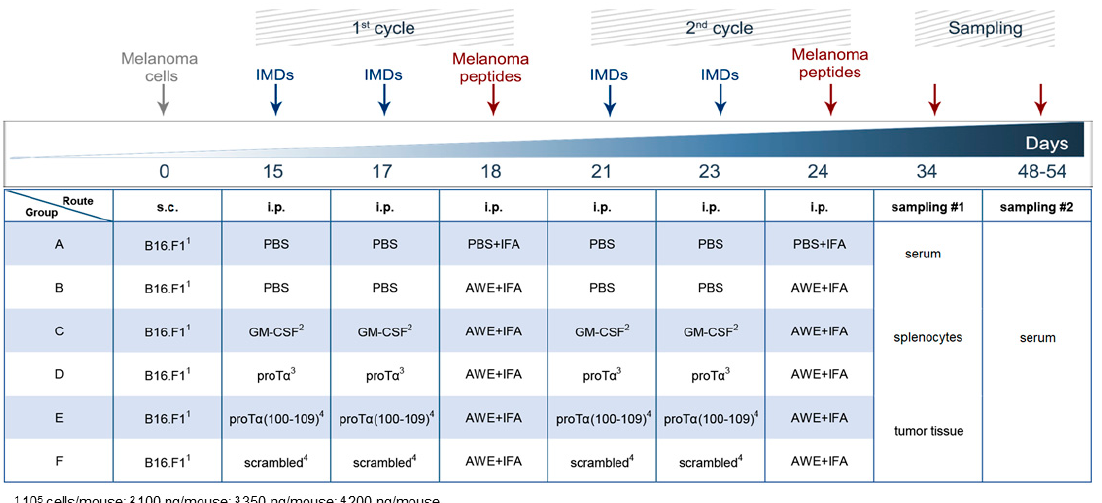
Figure 1. In vivo protocol used to assess effect of proT α and proT α (100–109). Day 0: Mice inoculated subcutaneously (s.c.) with syngeneic B16.F1 melanoma cells. Days 15, 17, 21, and 23: Mice of groups C, D, E, and F administered intraperitoneally (i.p.) granulocyte-macrophage colony-stimulating factor (GM-CSF), proT α , proT α (100–109), or scrambled decapeptide, respectively. Days 18 and 24: Mice of groups B, C, D, E, and F were administered i.p. melanoma peptide extract (AWE) mixed with incomplete Freund’s adjuvant (IFA). Sampling performed on days 34 and 48–54 as indicated.